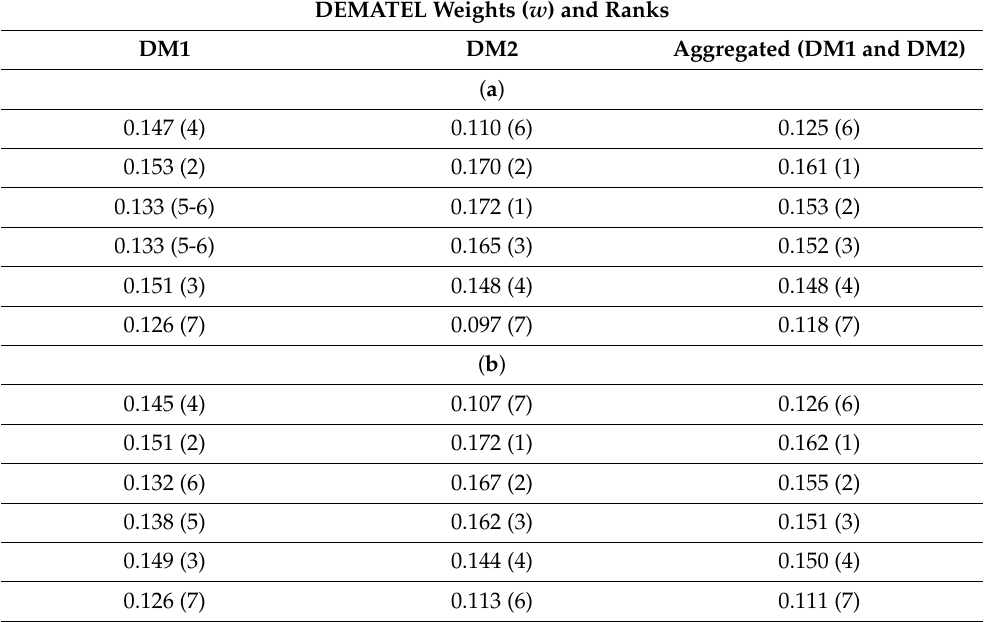
Table 7. ( a ) DEMATEL—Criteria weights obtained by relation (6) [2,45]. ( b ) DEMATEL—Criteria weights obtained by Formula (7)